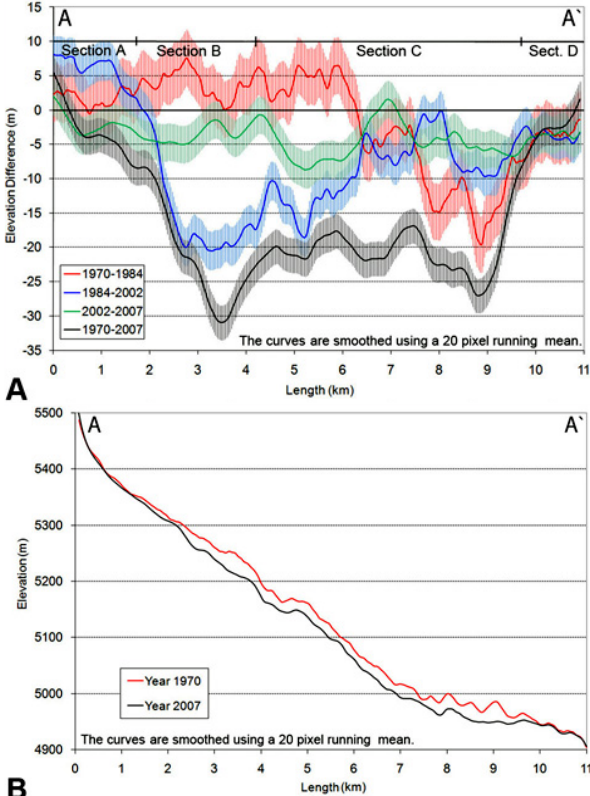
Fig. 6. (A) : Profiles of the DTM differences of Khumbu Glacier. (B) : Longitudinal profiles of the surface elevation of Khumbu Glacier 1970 and 2007. See Figs. 3 and 5 for the location of the